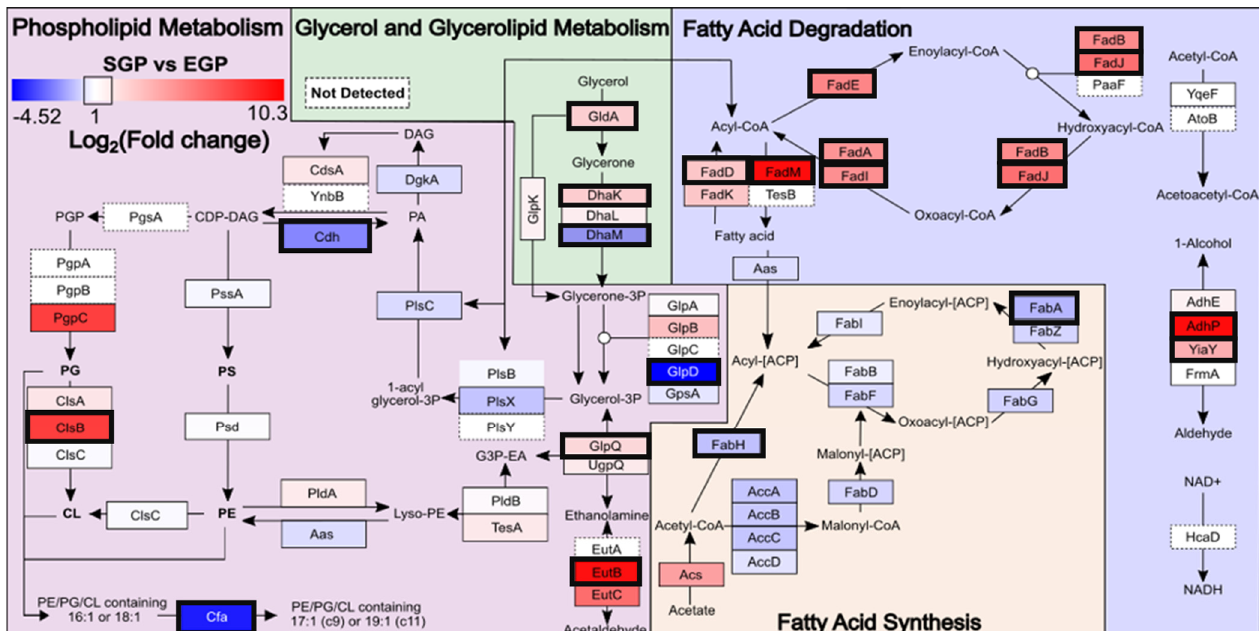
Figure 6. Pathway of E. coli lipid metabolism annotated to show alterations in lipid metabolism- associated protein abundances between EGP and SGP conditions. A heatmap is used to show proteins with increased abundance in either the EGP (blue) or SGP (red). Proteins whose abundance changes are statistically significant are annotated with a bold black box. Proteins not observed are annotated with a dashed white box. The full names and abbreviations of the enzymes labelled in this figure are shown in Supplementary Table S1.